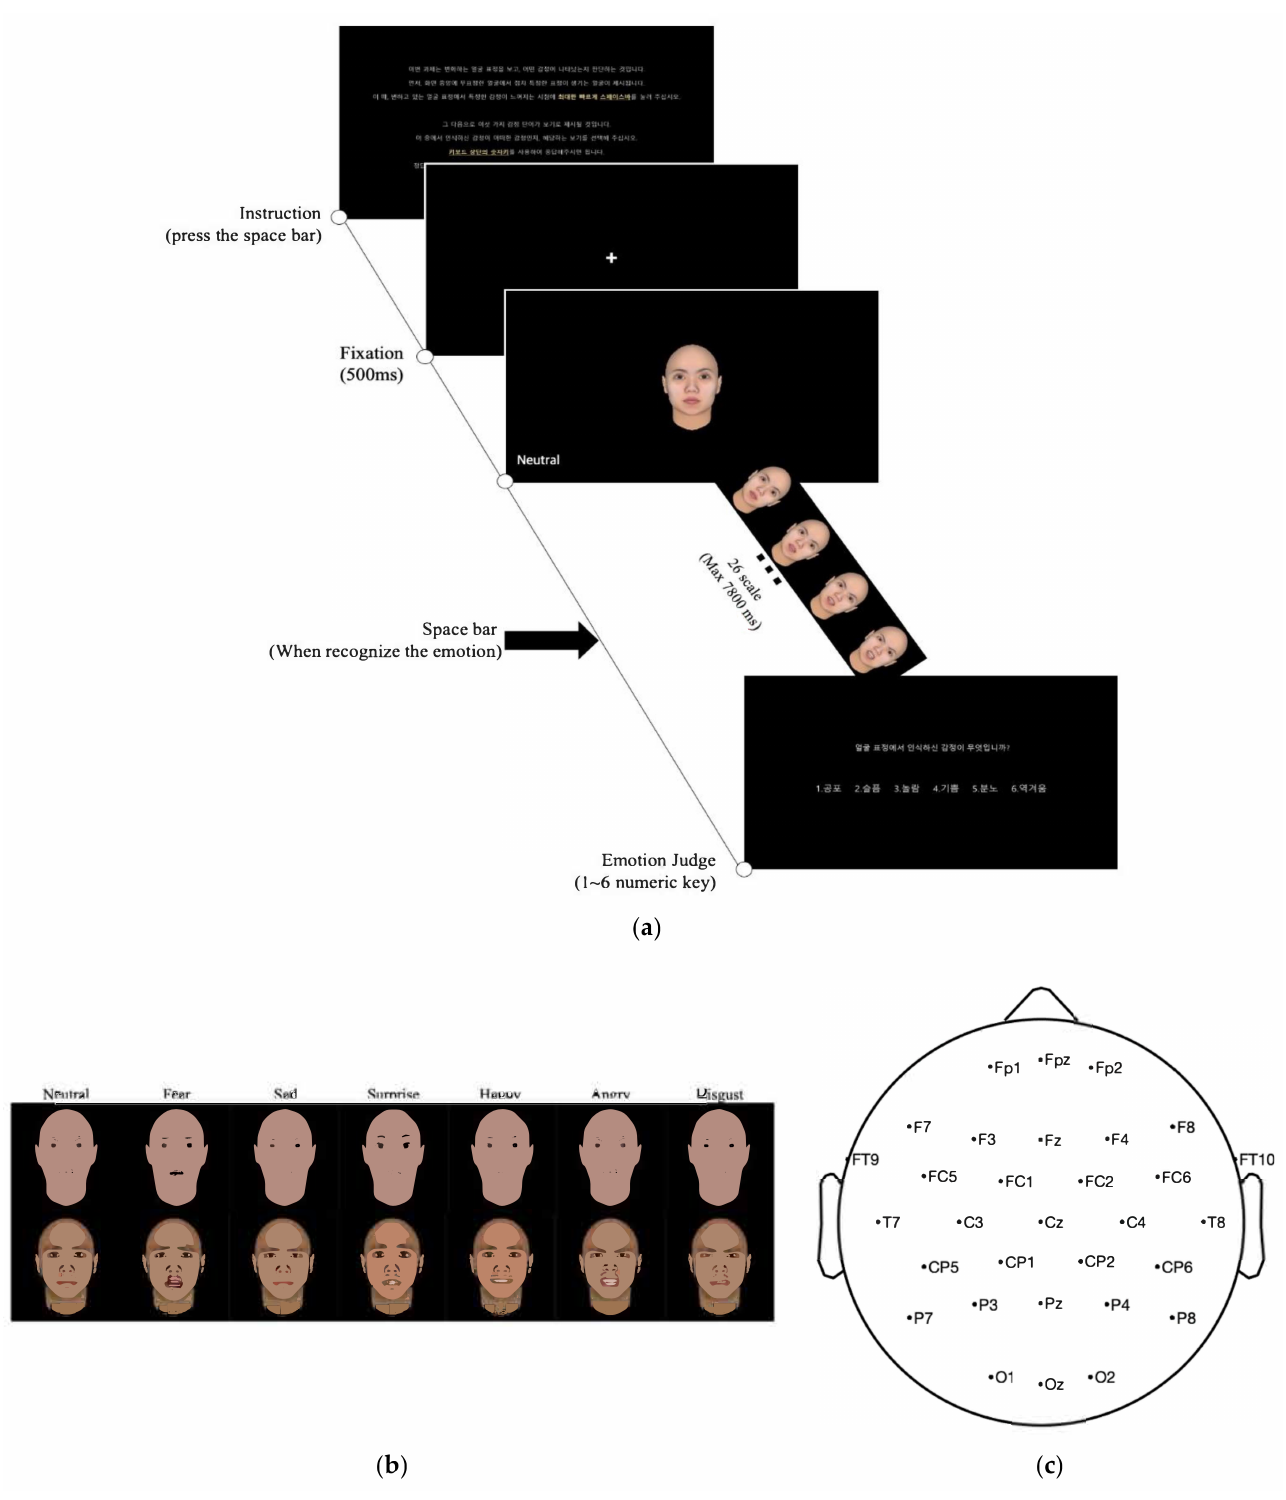
Figure 1. Figure about an experiment to acquire data. ( a ) Experiment protocol; ( b ) facial expression stimuli; the upper row is female, bottom is male. From left to right, the first is neutral face and in turn, the extreme expression of each emotion is shown; ( c ) EEG